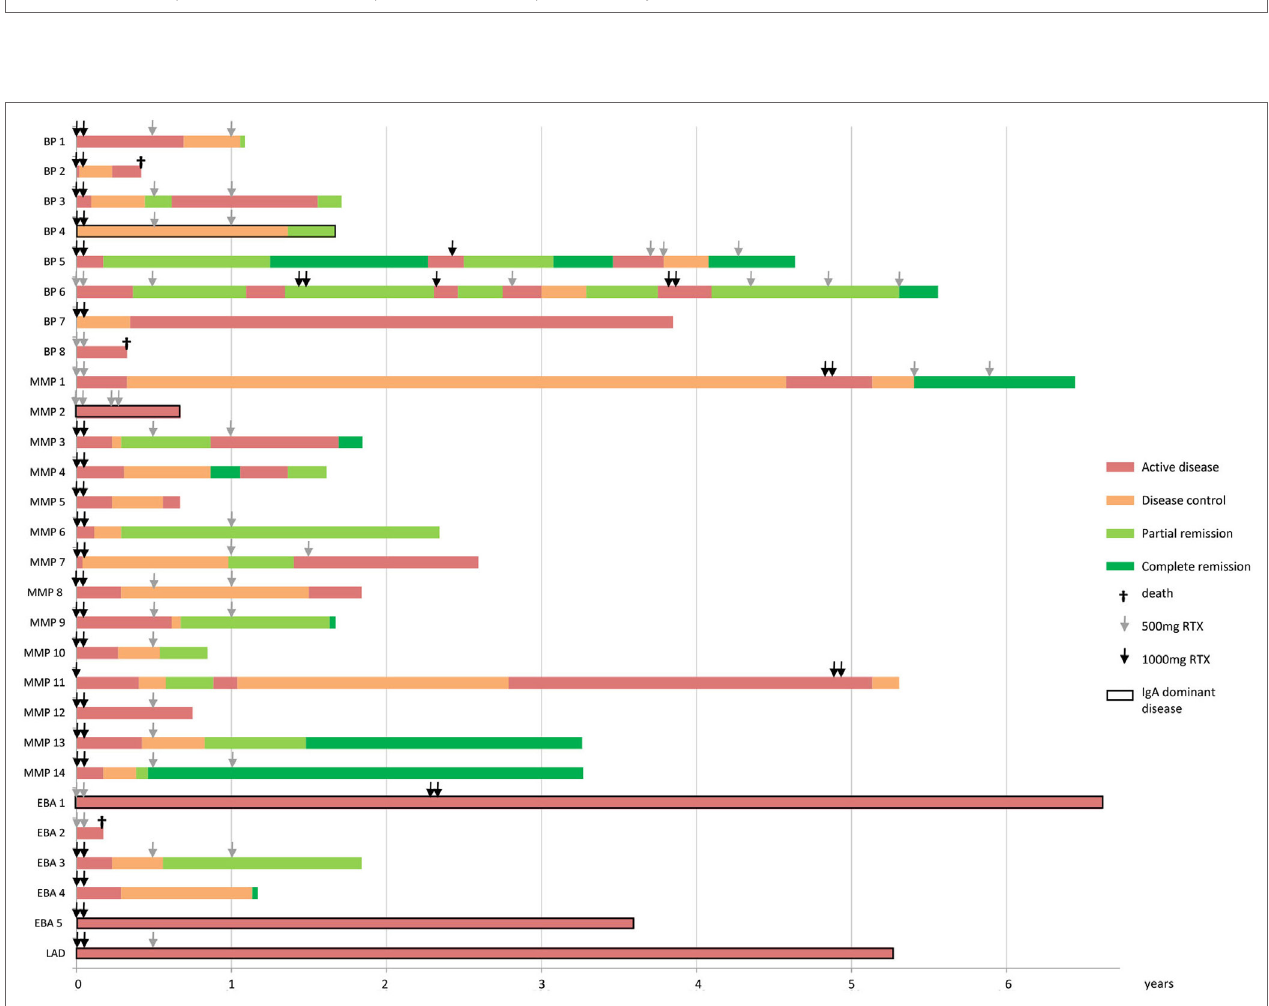
FigUre 4 | Bar chart showing the achieved endpoints and repeated treatment of RTX of each individual pemphigoid patient. Bars represent patients until the end of follow-up. The pemphigoid subtypes are indicated on the y -axis and the x -axis displays time in years. RTX, rituximab; BP, bullous pemphigoid; MMP, mucous membrane pemphigoid; EBA, epidermolysis bullosa acquisita; LAD, linear IgA